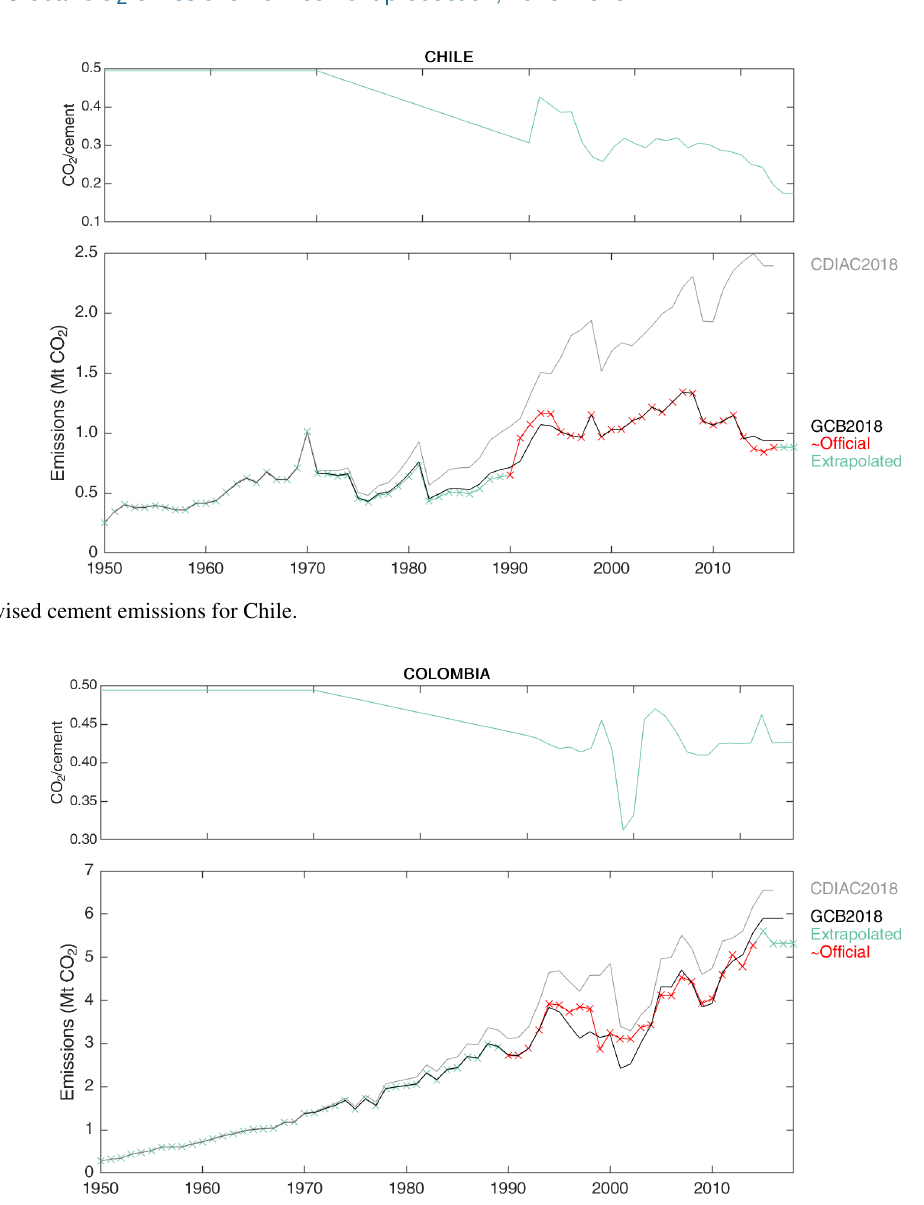
Figure C18. Revised cement emissions in